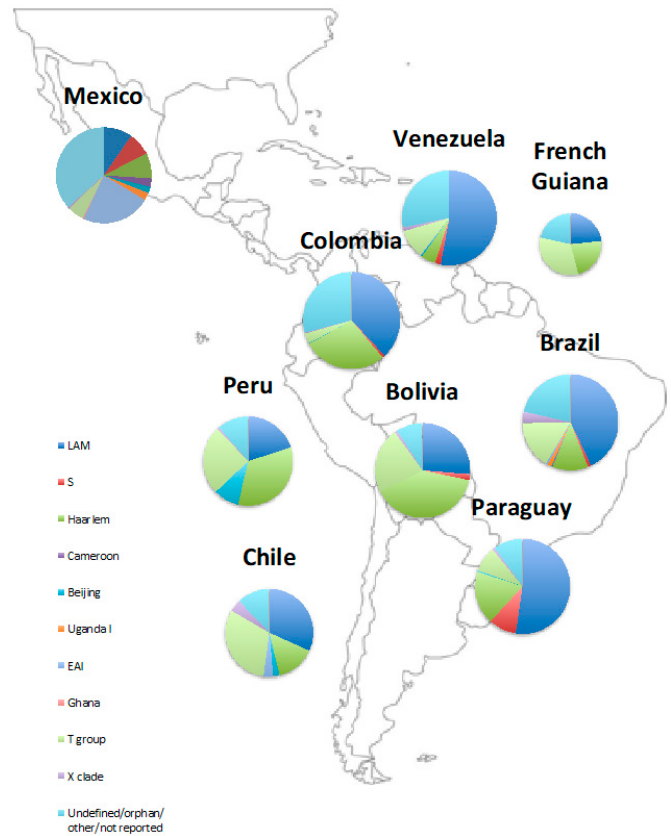
Figure 1. Distribution of phylogenetic groups in Latin America. References for data are included in Tables 1 and 2. The differences in MTB genotypes throughout Latin America are likely to be the result of different periods of human migration and colonisation over time — for example in Brazil, with initial Portuguese colonisers and the forced migration of large numbers of African slaves in the 16th – 18th centuries, followed by significant European immigration throughout the 19th and 20th centuries [43]. This may be the reason behind the development of the RD-Rio strain found disproportionately in Rio de Janeiro [44]. This contrasts with patterns of migration in other countries such as Argentina which experienced proportionately larger numbers of migrants from Europe and the Middle East